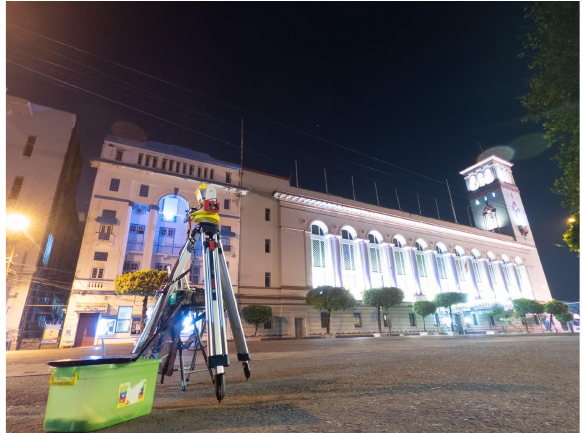
Figure 9. Test setup at Myanma Port Authority